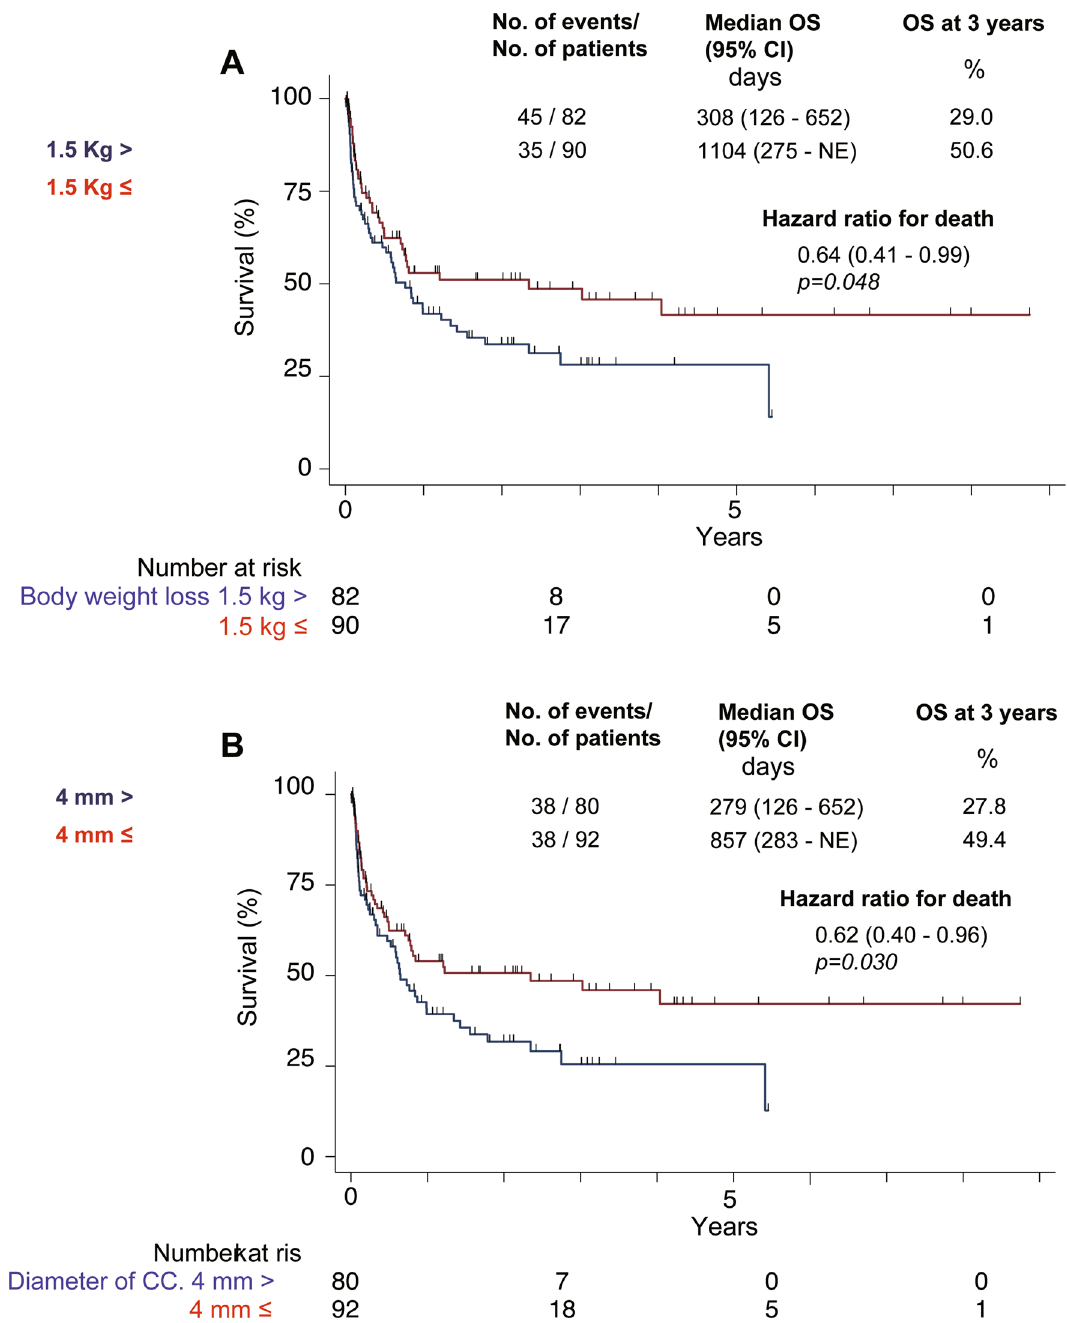
Figure 2. Cumulative liver transplantation-free survival rate. ( A ) Cumulative liver transplantation-free survival rates were significantly higher in the group achieving body weight reduction than in the group with incomplete body weight reduction. ( B ) Cumulative liver transplantation-free survival rates were significantly higher in the group that responded to tolvaptan than in the group not responding to